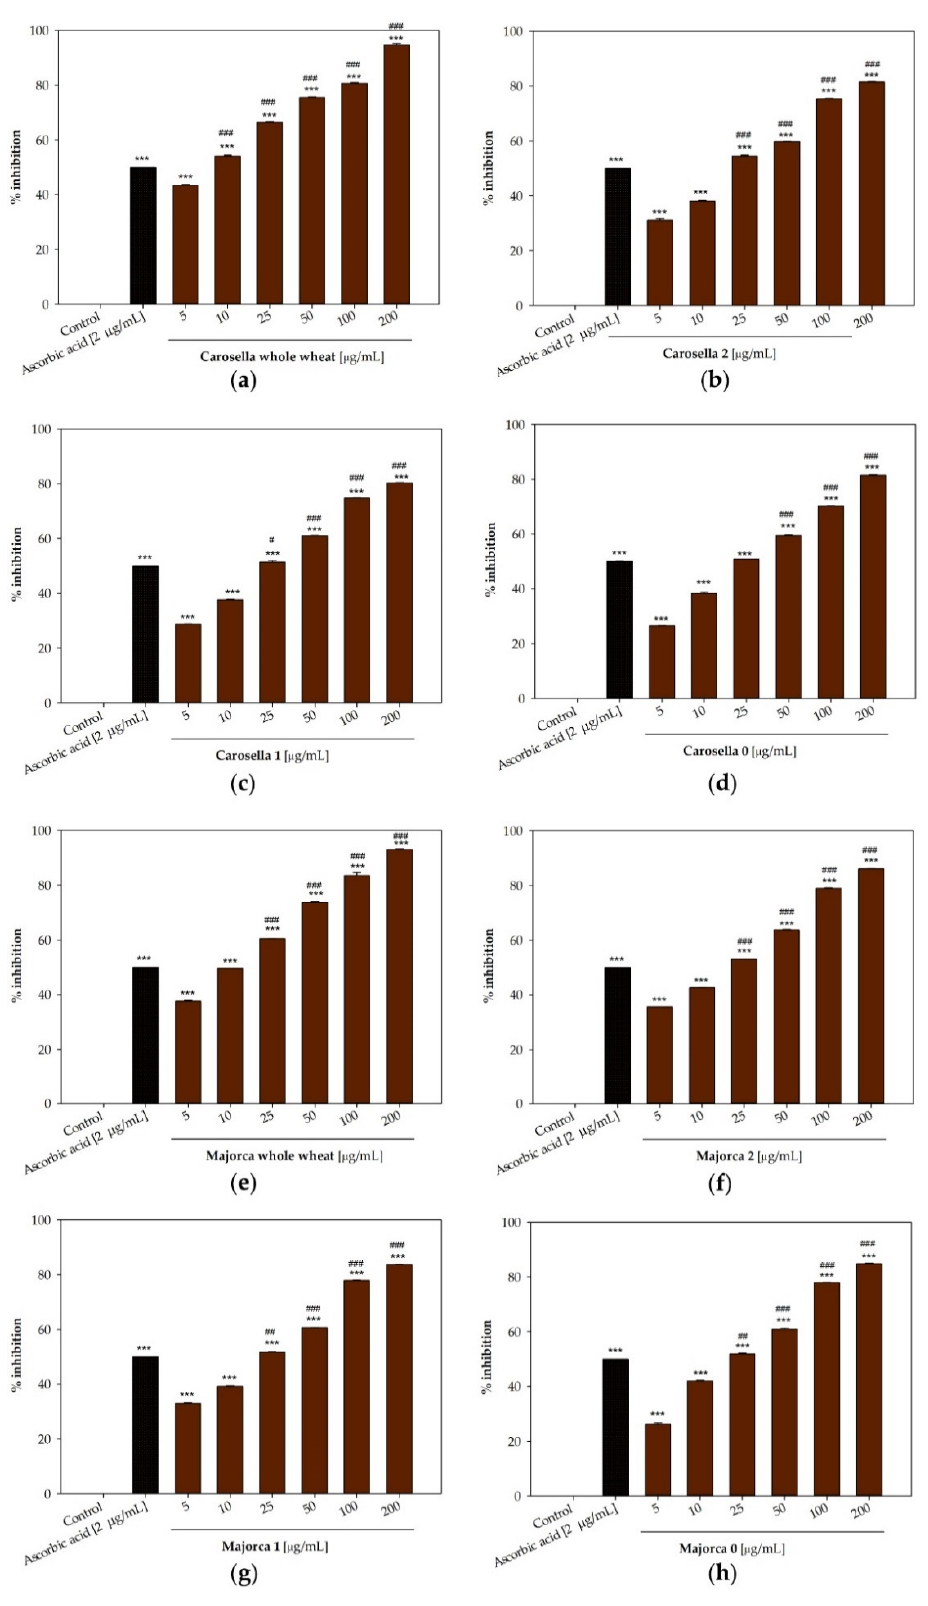
Figure 4. Radical scavenging activity of Carosella and Majorca samples. Ascorbic acid (2 μ g/mL) was used as positive control. Significant difference versus control: *** p < 0.001; significant difference versus ascorbic acid: # p < 0.05, ## p < 0.01, ### p < 0.001 (Dunnett ’ s multiple comparison test).